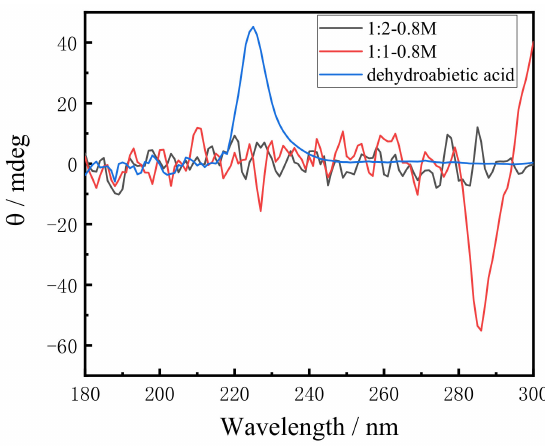
Figure 5. CD spectra of 1:1 and 1:2 system of dehydroabietic acid to morpholine and dehydroabi- etic